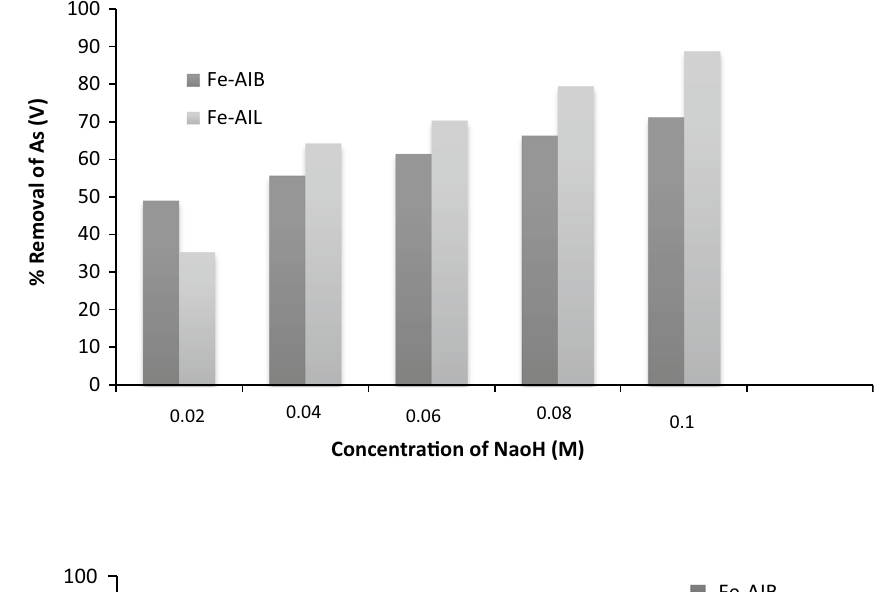
Fig. 17 Variation in percentage removal of As(VI) by repetitive use of Fe-AIB and Fe-AIL